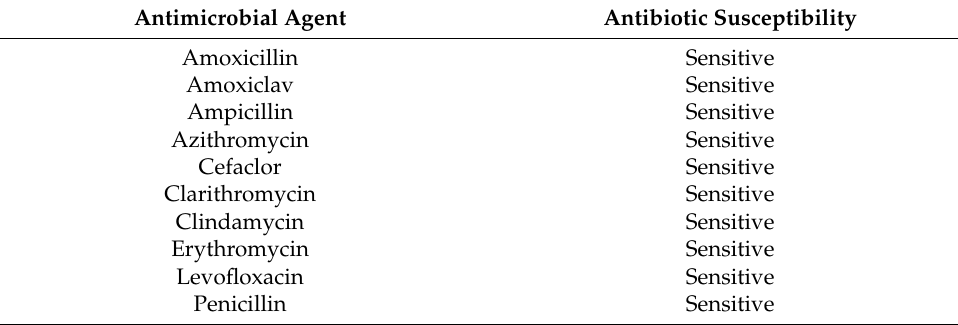
Table 1. Antibiotic susceptibility test of Streptococcus pyogenes .